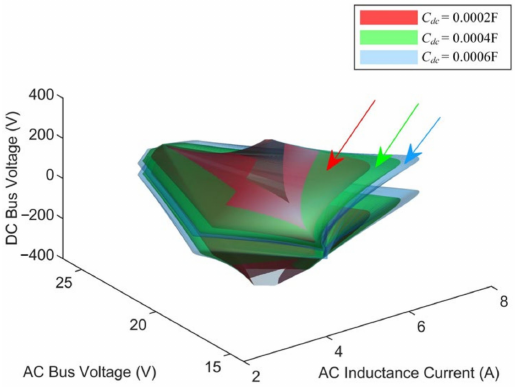
Figure 25. Different 3D RAS of microgrids when DC bus capacitors are 0.0002 F, 0.0004 F and 0.0006